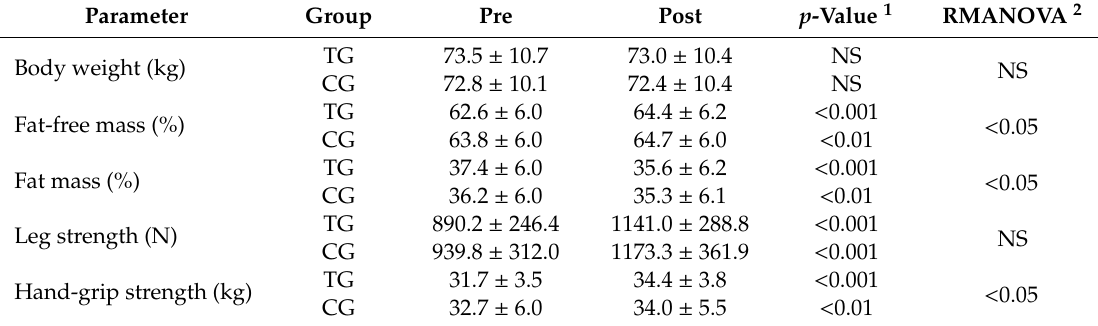
Table 2. Body composition and muscle strength in the subjects before (pre) and after (post) the intervention in the treatment group (TG) or control group